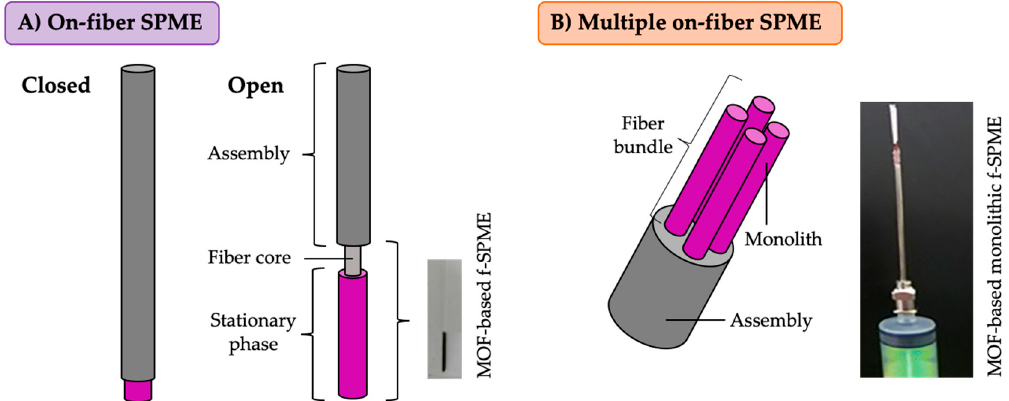
Figure 4. ( A ) Scheme of a generic f-SPME device and image of a MOF-based f-SPME. Adapted from [78], with permission from Elsevier, 2019. ( B ) Scheme of a generic multiple f-SPME device and image of the MOF-based monolithic f-SPME. Adapted from [70], with permission from Springer, 2019.